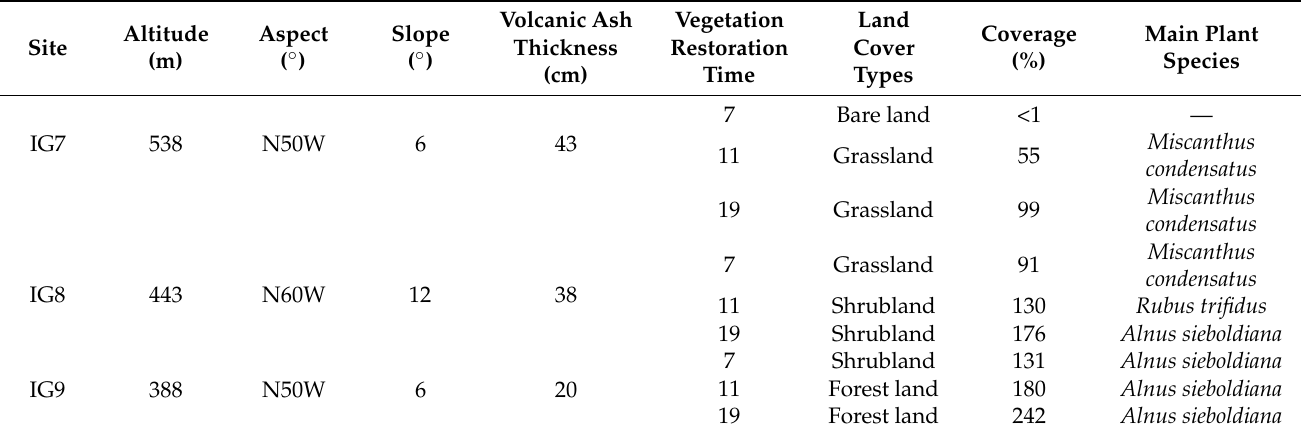
Table 1. Geographical and vegetation characteristics of the three study